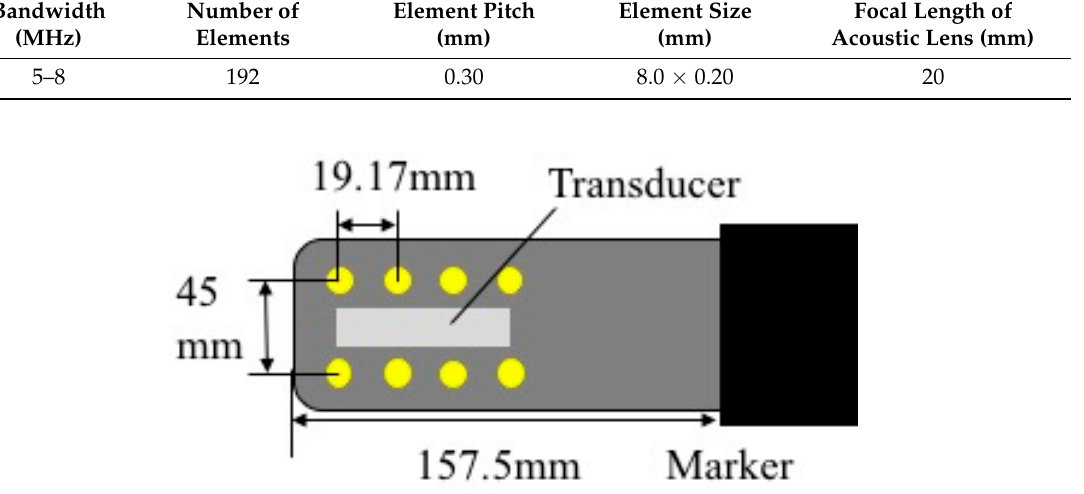
Table 1. Specifications of the array transducers used in MRI.